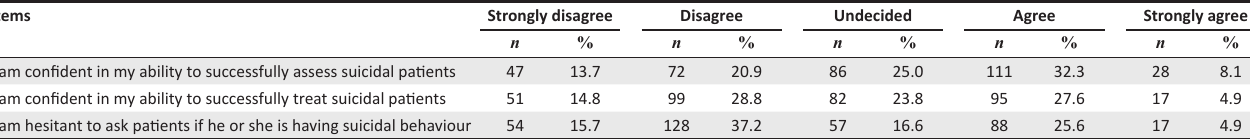
TABLE 3: Self-competency to treat suicidal behaviour patients. Items Strongly